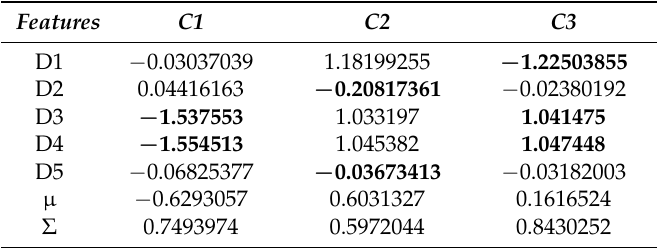
Table 6. Difference Factor of each Feature in each Cluster. Bold numbers are salient features which are out of range of 1 standard deviation from